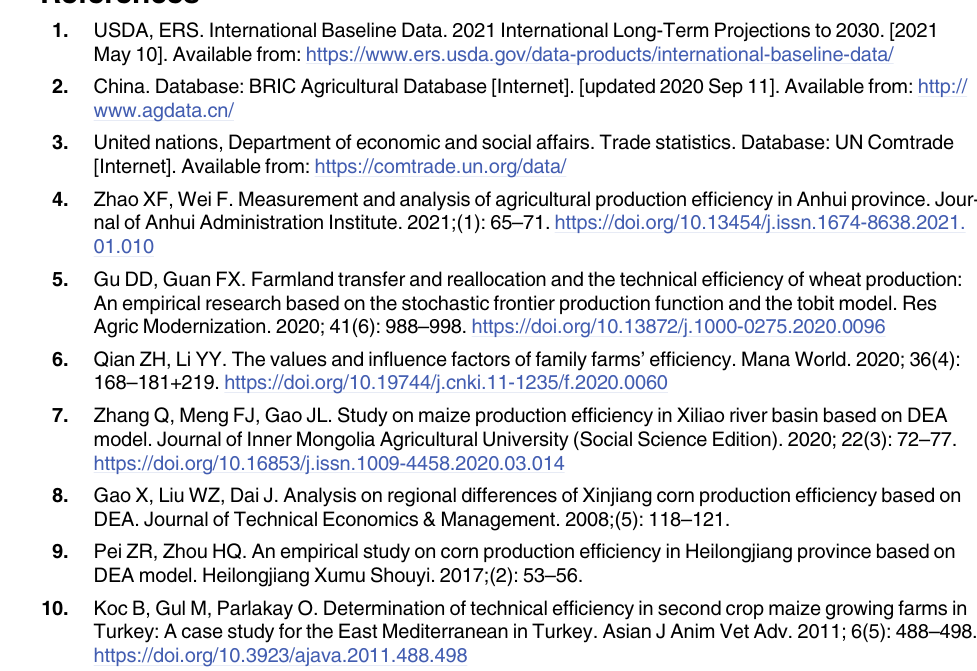
S2 Table. Model variable settings and descriptive